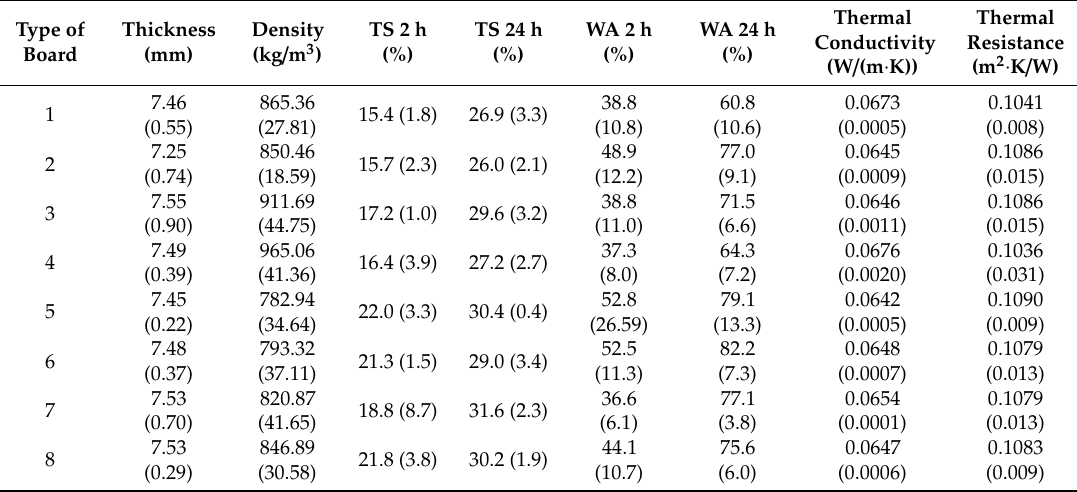
Table 2. Average results of physical and thermal